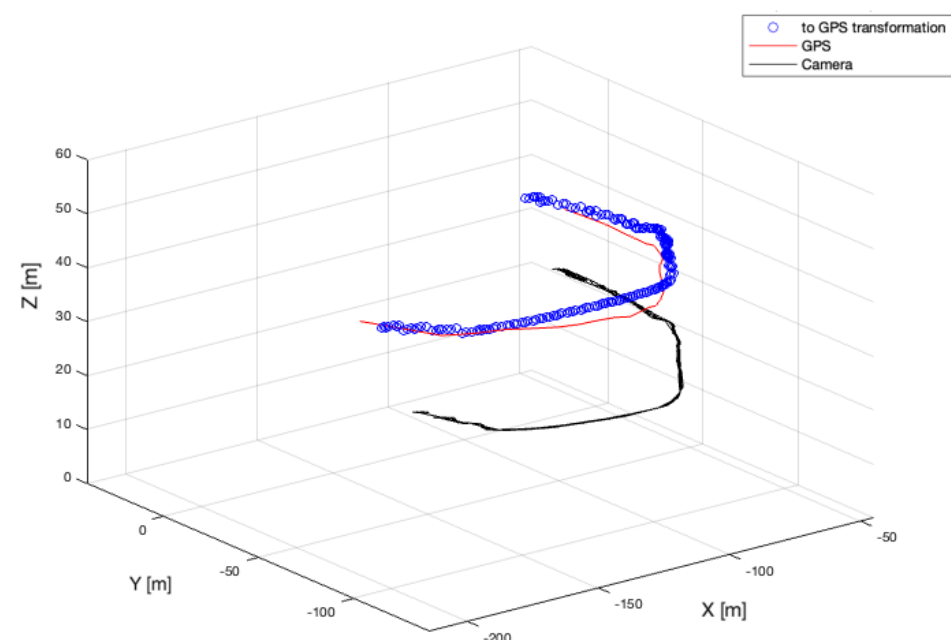
Figure 14. Transformation of camera coordinate system into GPS coordinate system.